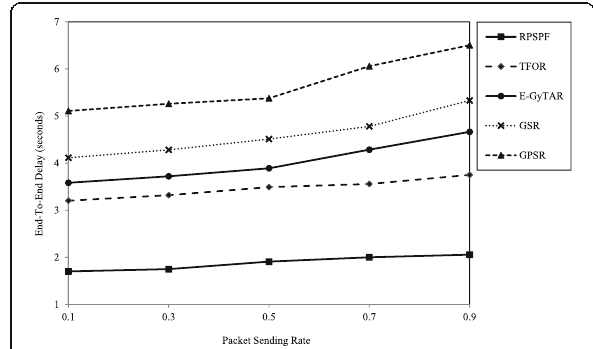
Fig. 9 End-to-end delay as a function of the packet sending rate (400 nodes). RPSPF represents Reliable Path Selection and Packet Forwarding Routing Protocol which is proposed approach and is represented by a solid line with a square. TFOR is traffic flow- oriented routing protocol and is represented by a dashed line having rhombus. E-GyTAR is Enhanced Greedy Traffic Aware Routing protocol and is represented by a solid line with circle. GSR is geographic source routing protocol and is presented by a dotted line having a cross. GPSR is Greedy Perimeter Stateless Routing Protocol and is presented by a dashed line having a